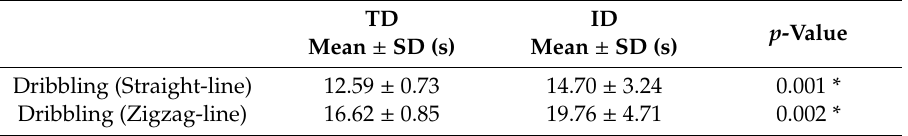
Figure 12. Results of D dribbling _ straight and D dribbling _ zigzag . The participants with ID exhibited longer dribbling distances than the TD participants in both tests. Table 8. ANOVA results of the dribbling distance for the two groups.